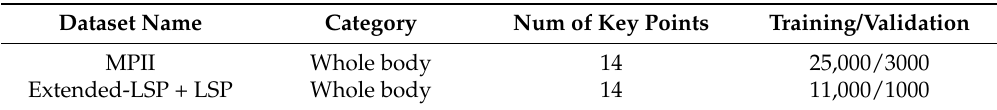
Table 4. The basic information of the